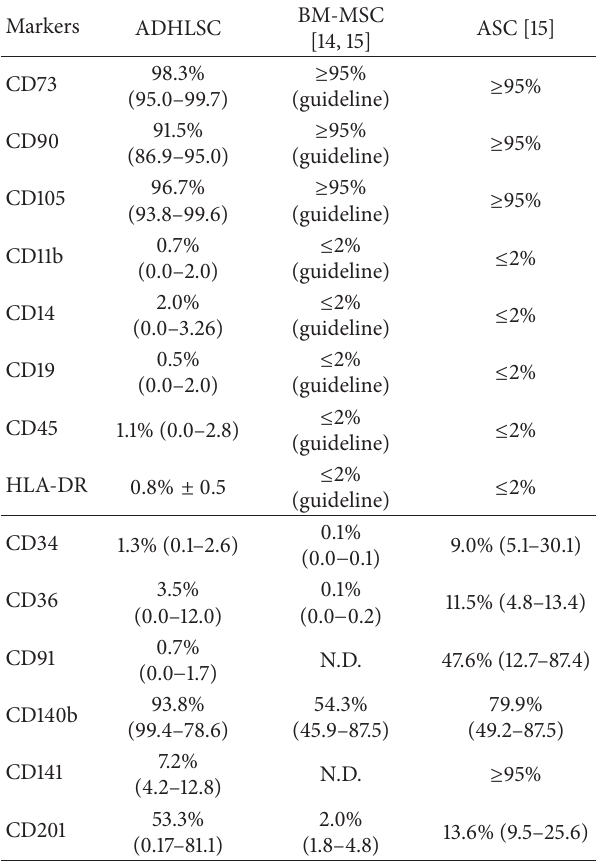
Table 2: Expression of MSC markers of ADHLSCs and comparison with BM-MSC and